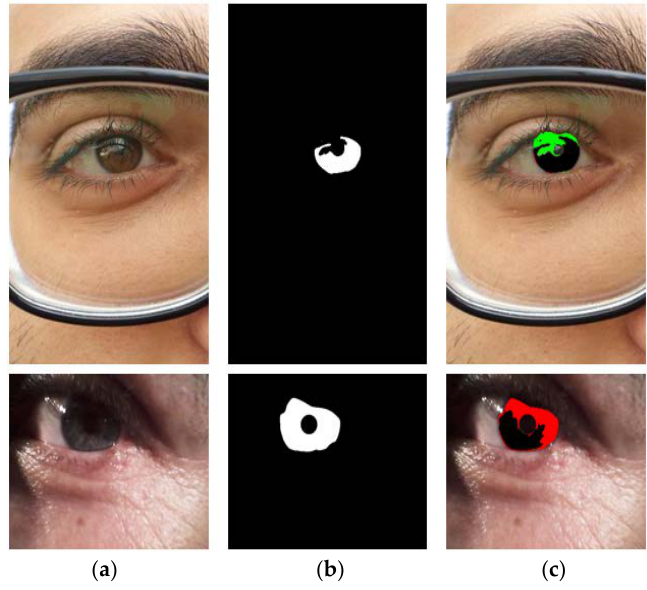
Figure 18. Examples of MICHE-I incorrect segmentation results by our method. ( a ) Original image. ( b ) Ground-truth image. ( c ) Segmentation result by IrisDenseNet (The false positive and negative errors are presented as green and red, respectively. The true positive case is presented as black). Table 5. Comparison of the proposed method with previous methods using MICHE-I dataset based on NICE-I evaluation protocol.